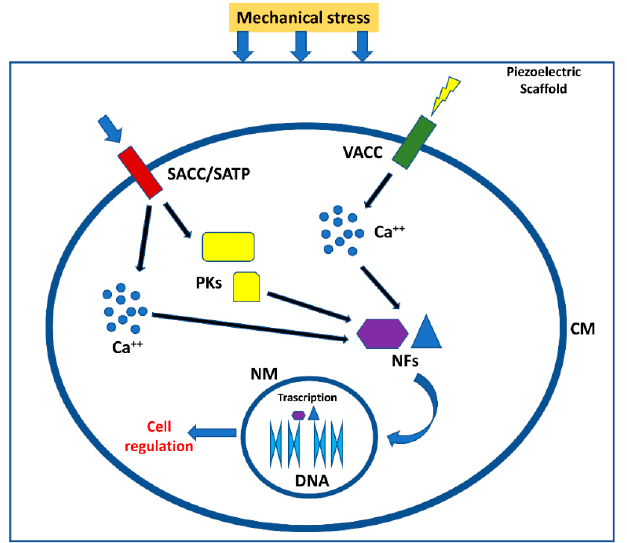
Figure 2. Effect of piezoelectric biomaterials on the cells. Mechanical stress compresses the scaffold or ECM generating the activation of voltage-dependent channels and channel/transmembrane proteins activated by mechanical stimuli. Calcium ions and protein kinases generate a signal cascade that in turn activate nuclear factors able to migrate in cell nuclei, generating different cell responses [4]. SACC = stretch activated calcium channels; SATP = stretch activated transmembrane proteins; VACC = Voltage activated calcium channels; PKs = protein kinases; NFs = nuclear factors; CM = cell membrane; NM = nuclear membrane.